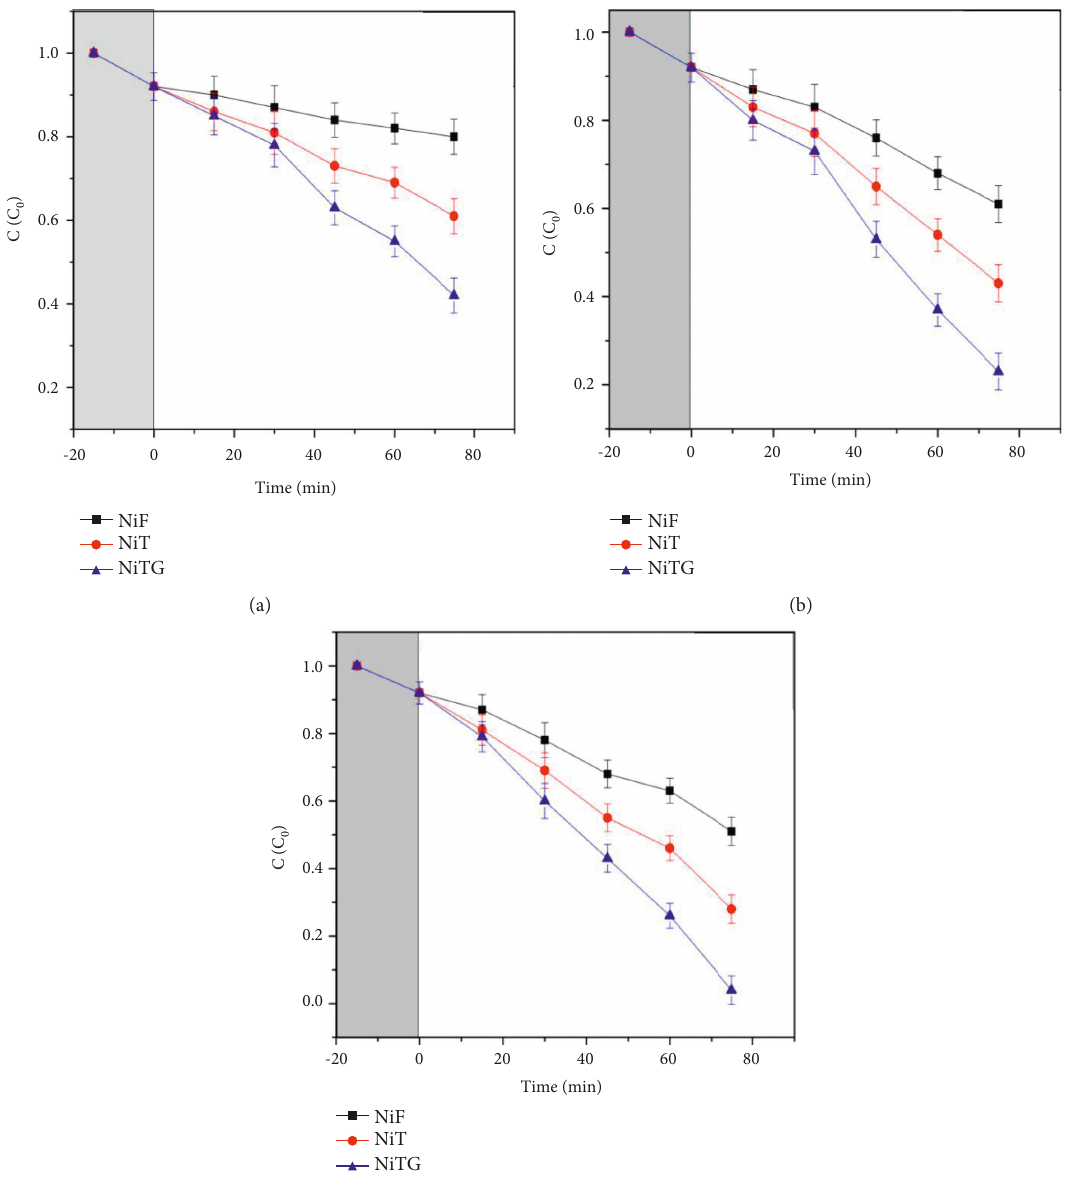
Figure 11: C/C 0 versus time plot of TC degradation by (a) sonocatalytic; (b) photocatalytic; (c) sonophotocatalytic